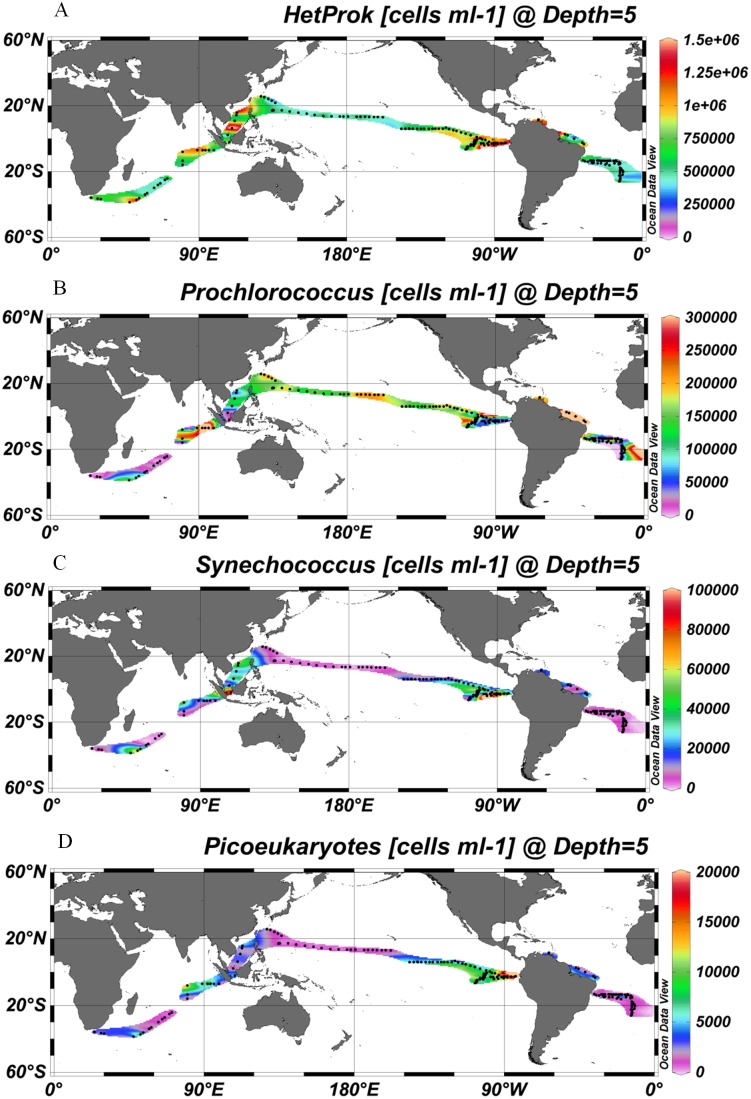
A global distribution pattern of the heterotrophic prokaryotic cell abundance (A), Prochlorococcus (B), Synechococcus (C) and picoeukaryotes abundance (D).The map was generated with Ocean Data View software [40].